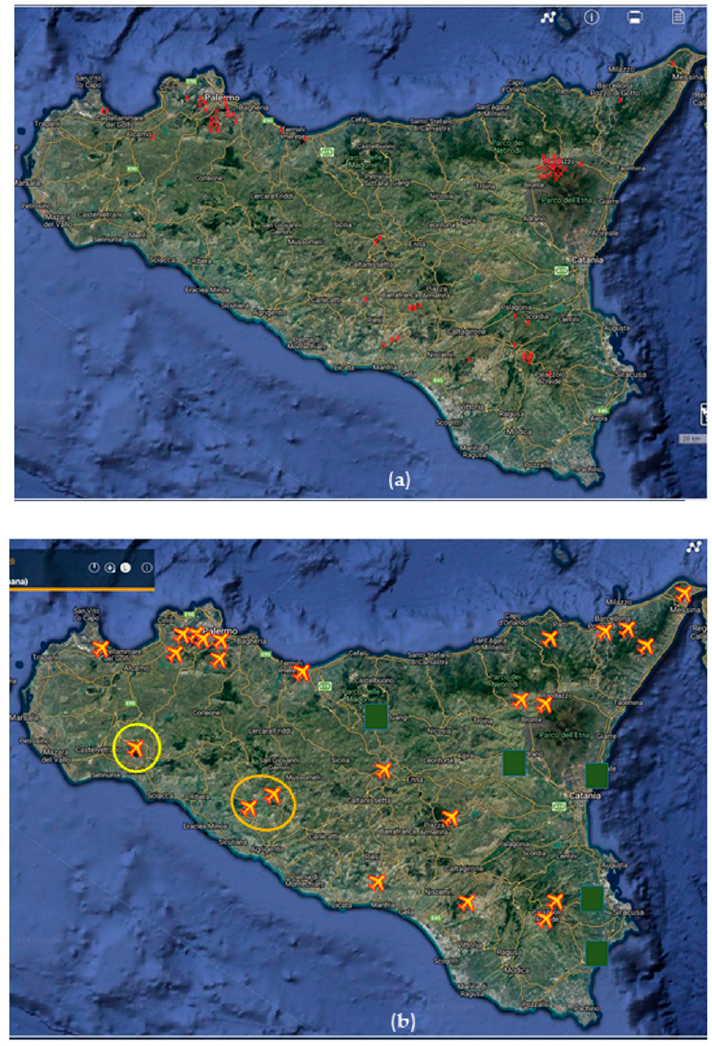
Figure 8. Comparison between ( a ) zoom on the Sicily region of the map of burned areas generated by AUTOBAM from the S2 acquisition on 6 August 2019, and ( b ) map derived from the local fire signaling in the period 2–6 August 2019. Red crosses: AUTOBAM-burned areas; yellow airplanes: location of the fires according to local fire signaling. Local signaling not regarding forests are not considered (masked by green boxes in panel ( b )). Both maps are available from the MyDewetra platform. Yellow and orange circles highlight the fires reported by local news, which were not detected by AUTOBAM.